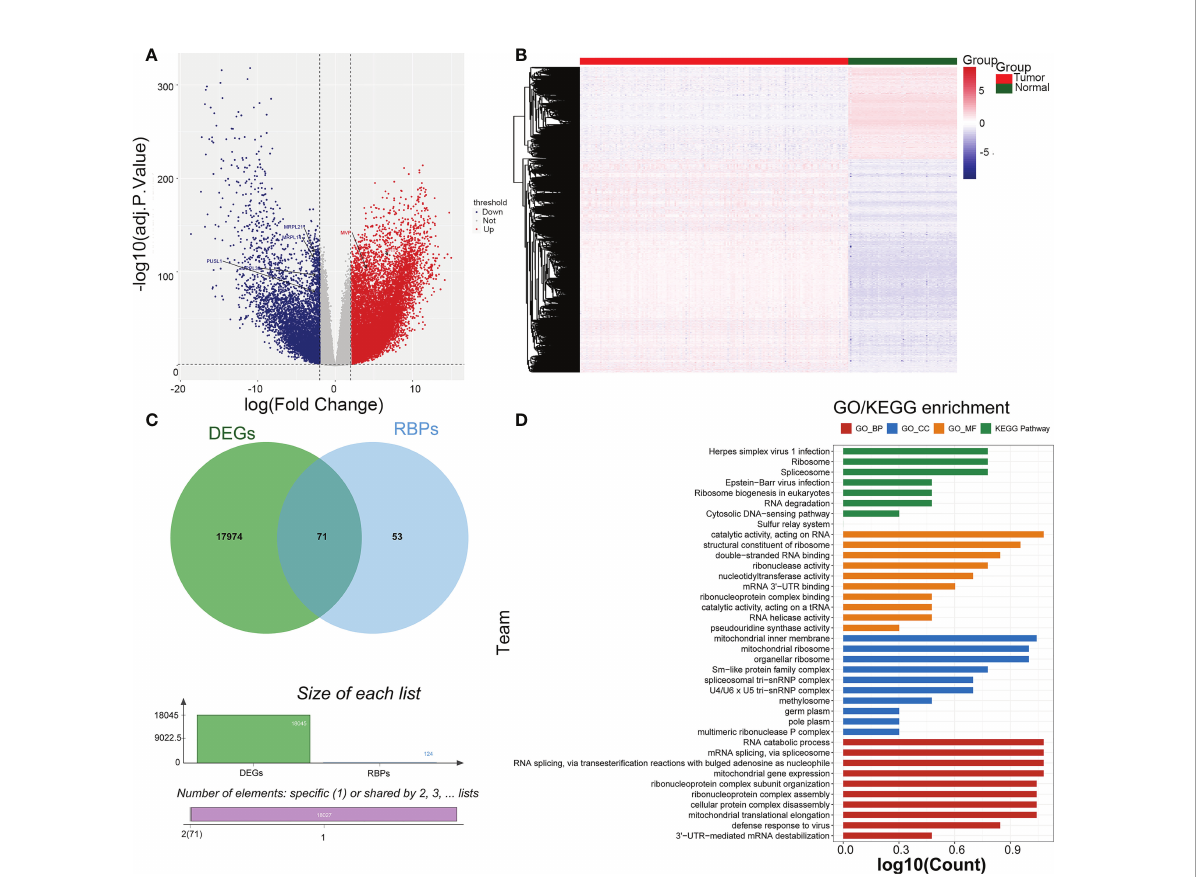
FIGURE 1 Identi fi cation of pyroptosis-RNA-binding protein (RBP)-related differentially expressed genes (PRBP-DEGs). (A) Volcano plot of PRBP-DEGs between AML and normal samples, the red and blue dots indicate up-regulated and down-regulated genes with adj. p < 0.05 and |log 2 fold change (FC)| > 2 setting as criteria. (B) Heatmap of PRBP-DEGs in AML and normal samples. (C) A Venn-gram of DEGs and pyroptosis-related RPB genes. (D) Bar plot of Gene Ontology (GO) enrichment analysis and Genes and Genome (KEGG) pathway analysis, p < 0.05 were set as